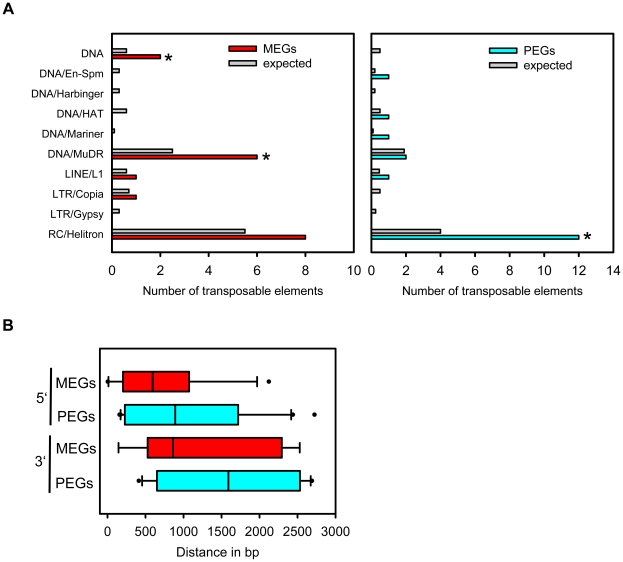
Types of Transposable Elements in the Vicinity of MEGs and PEGs.(A) Type of transposable elements present in MEGs (left panel) and PEGs (right panel) in comparison to their representation among detectable genes in our dataset (gray bars). TE superfamilies are as defined by TAIR (www.arabidopsis.org). (B) Distance of transposable elements in relation to the transcriptional start (5′ location) or stop (3′ location) of MEGs and PEGs.